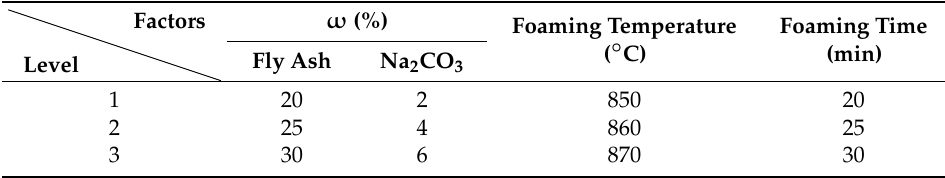
Table 2. The L 9 (3 4 ) Orthogonal test factors and levels.